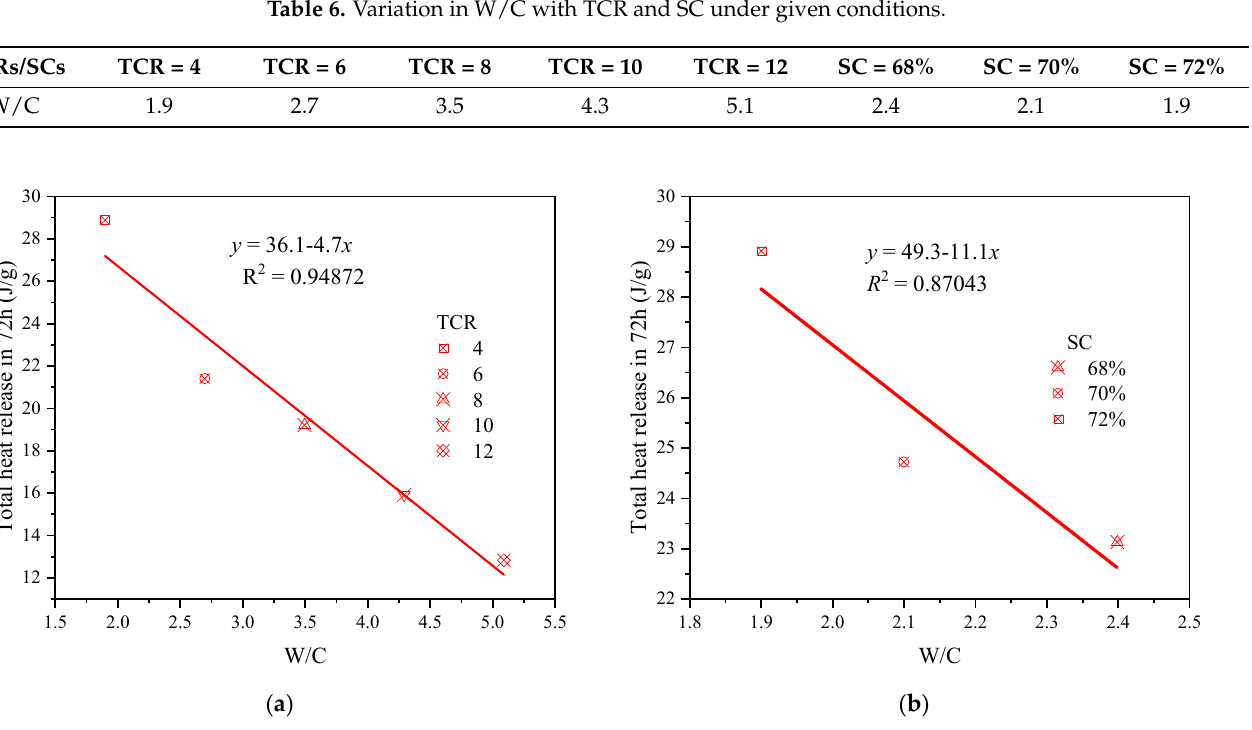
Figure 7. The effect of W/C on the total heat release Q under certain conditions: ( a ) SC = 72%; ( b ) TCR = 4.